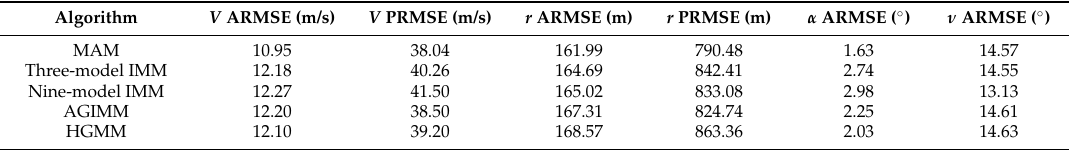
Table 2. The performances for stably tracking Scenario